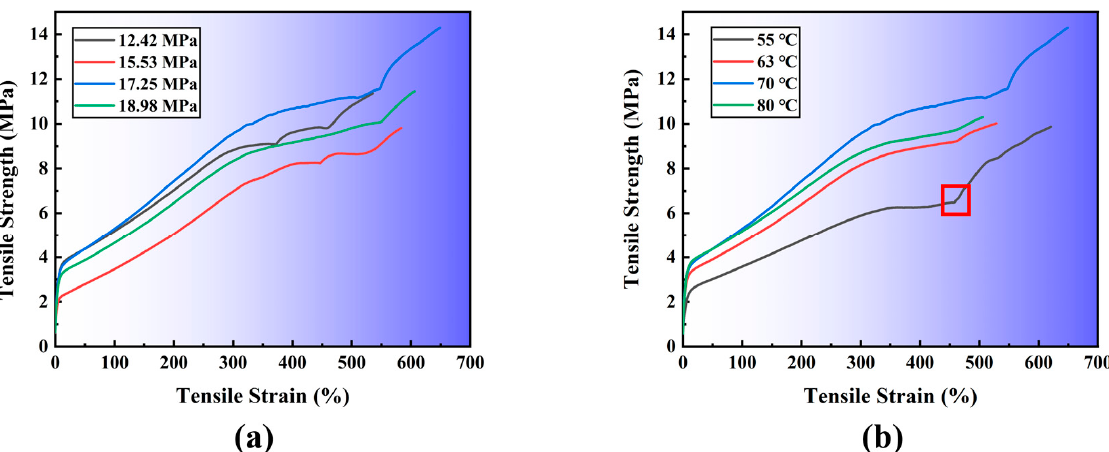
Figure 4. Tensile stress–strain curves of polyurea under different conditions: ( a ) different spraying pressures under the same temperature; and ( b ) different spraying temperatures under the same pressures. (Red Square is due to secondary loading.)